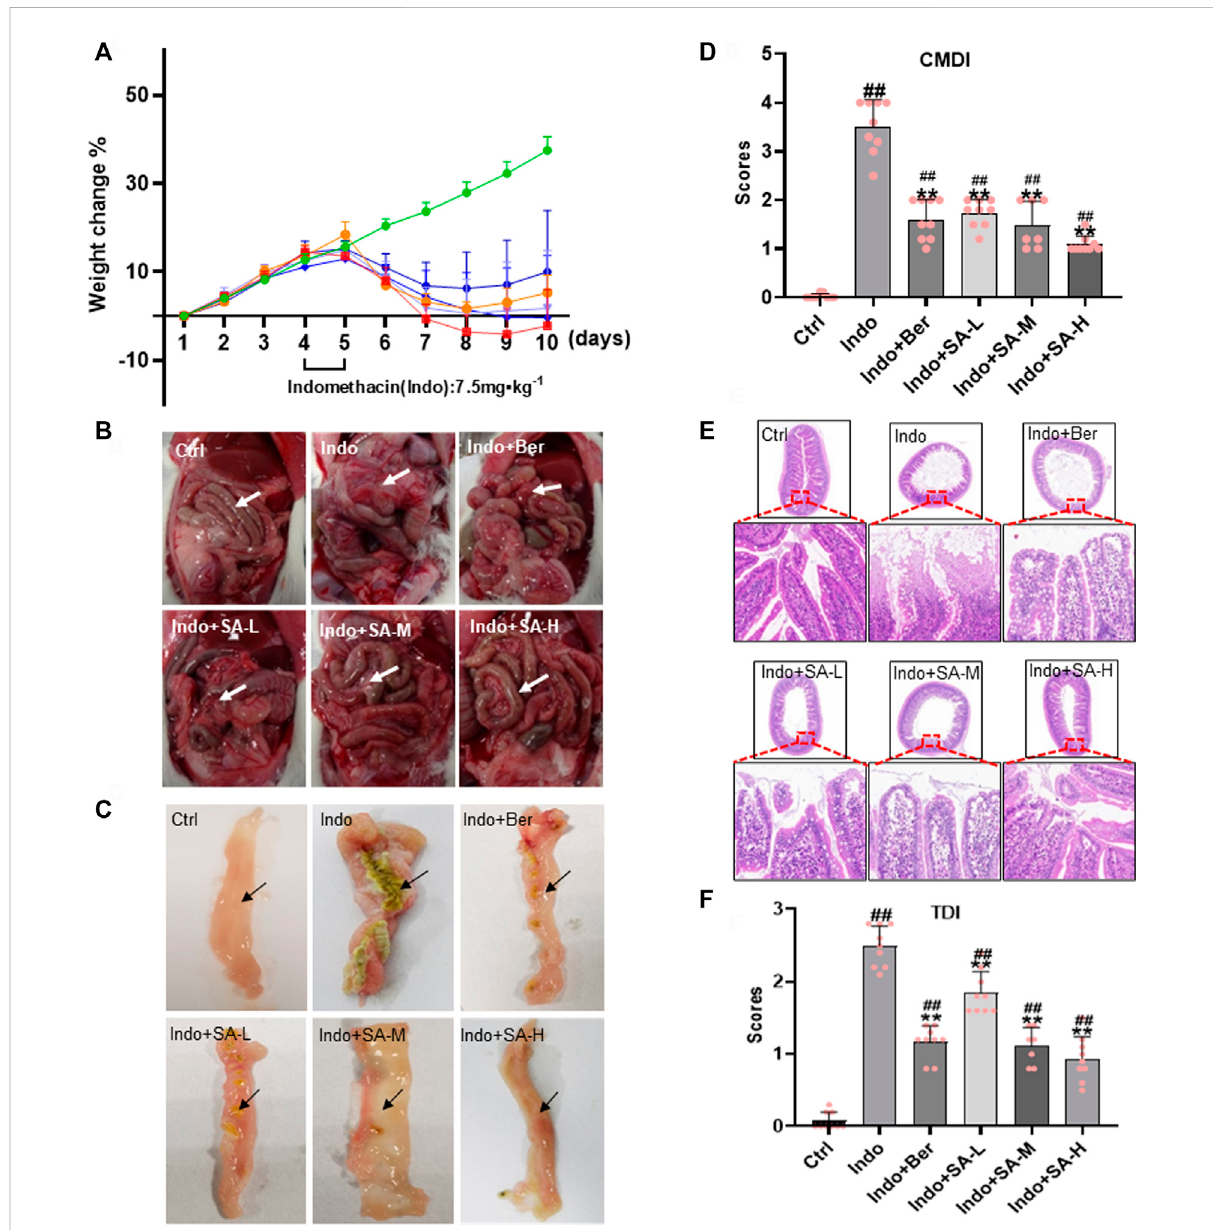
FIGURE 1 Protection of SA on small bowel in fl ammatory lesions induced by indomethacin in rats. Male SD rats at 180 – 200 g were treated with indomethacin (Indo, 7.5 mg kg − 1 ) alone or with sanguinarine (SA, 0.33 mg kg − 1 , 1.0 mg kg − 1 , 3.3 mg kg − 1 , SA-L, SA-M and SA-H, respectively) or with berberine (Ber,60 mg kg − 1 ).Tissue sections ofthejejunumandH&E (Hematoxylinandeosin) stainingwereprepared. (A) The bodyweightchangeof rats. (B) Grossdamageofsmallintestine. (C) Jejunumintimamacroscopyobservations,showingmucosallesions. (D) Colonicmucosaldamage index (CMDI). (E) Representative images of jejunum histology (magni fi cation at ×200). (F) Tissue damage index (TDI). Arrows indicate typical pathological changes. Data are presented as the mean ± SD ( n = 9). # p < 0.05 and ## p < 0.01 vs., control (Ctrl). * p < 0.05 and ** p < 0.01 vs. indomethacin